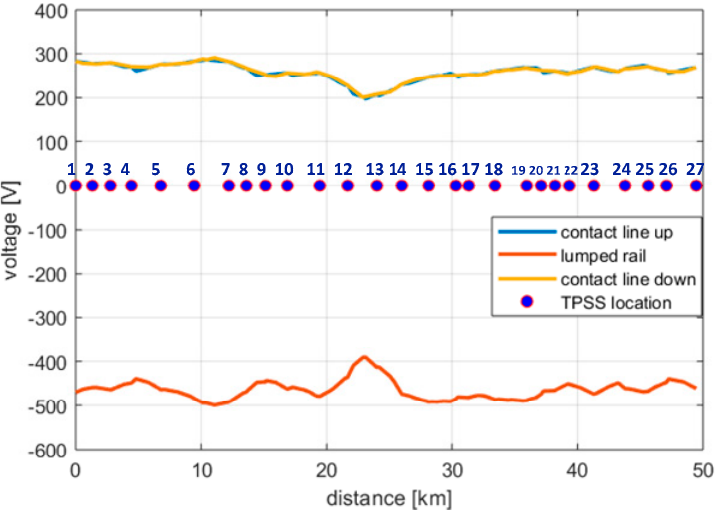
Figure 18. Network voltage against the location.